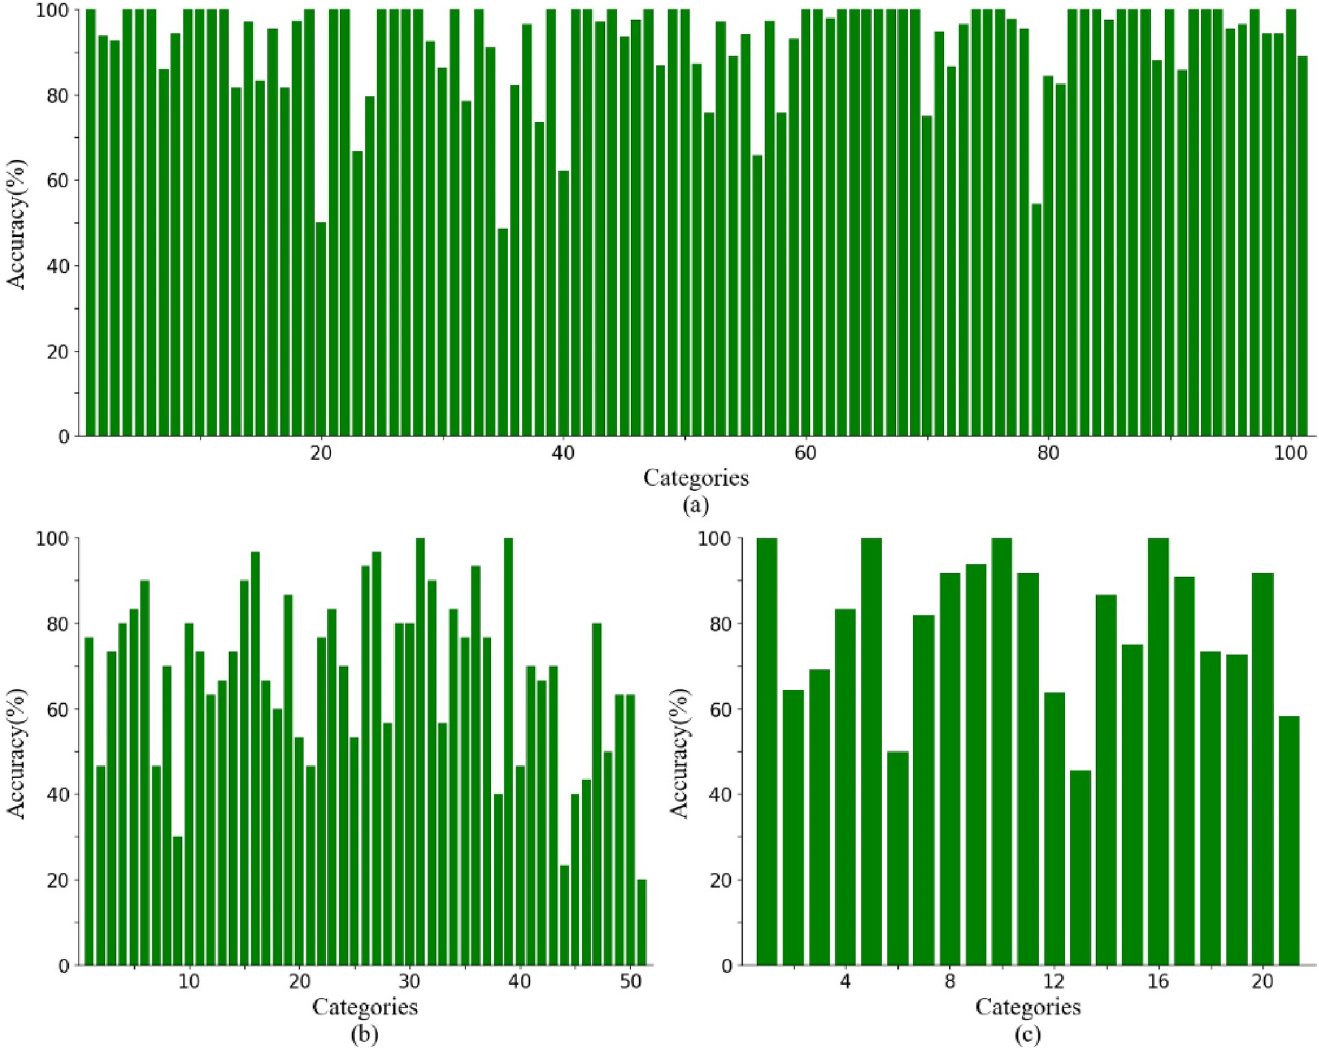
Fig 4. Category accuracy of the test set on three datasets (split 1) using our STA-TSN. (a) UCF101 dataset, (b) HMDB51 dataset, and (c) JHMDB dataset. Horizontal axis represents classes and the vertical axis shows accuracies for the corresponding class for the test set.